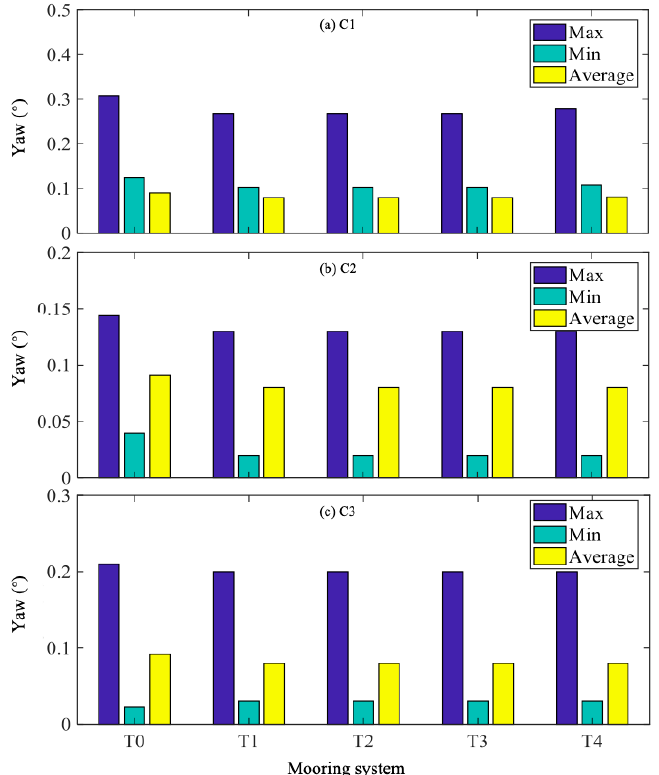
Figure 12. Yaw movement maximum, minimum, and average values in ( a ) C1, ( b ) C2, and ( c ) C3.